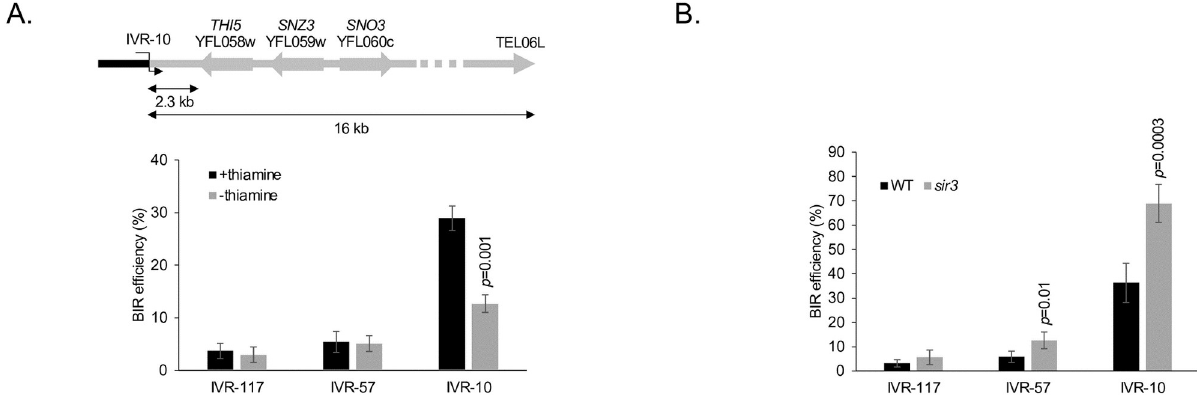
Fig 4. Ectopic BIR efficiency is decreased by cis-acting factors including transcription and heterochromatin of the template chromatid. A . A chromosome translocation positioned the last 16 kb of the left arm of chromosome VI downstream of the IVR-10 BIR initiating locus. This region contains the THI5 , SNZ3 and SNO3 genes whose transcription is active in the absence of thiamine in the growth medium and inactive in its presence. The arrows indicate the transcription orientation of the corresponding genes. Values are the means of three independent experiments in the presence of thiamine and four experiments in the absence of thiamine. Indicated is the Student’s t -test p -value < 0.05 when comparing BIR efficiency with or without thiamine in the growth medium. B . BIR efficiency from the IVR-117, IVR-57 and IVR-10 loci in a sir3 null mutant. WT values are identical to those in Fig 3. The sir3 values correspond to the means of five independent experiments. Indicated are Student’s t -test p -values < 0.05 when comparing BIR efficiency from a given locus in the mutant strain with the BIR efficiency from the same locus in the WT strain. Error bars represent standard